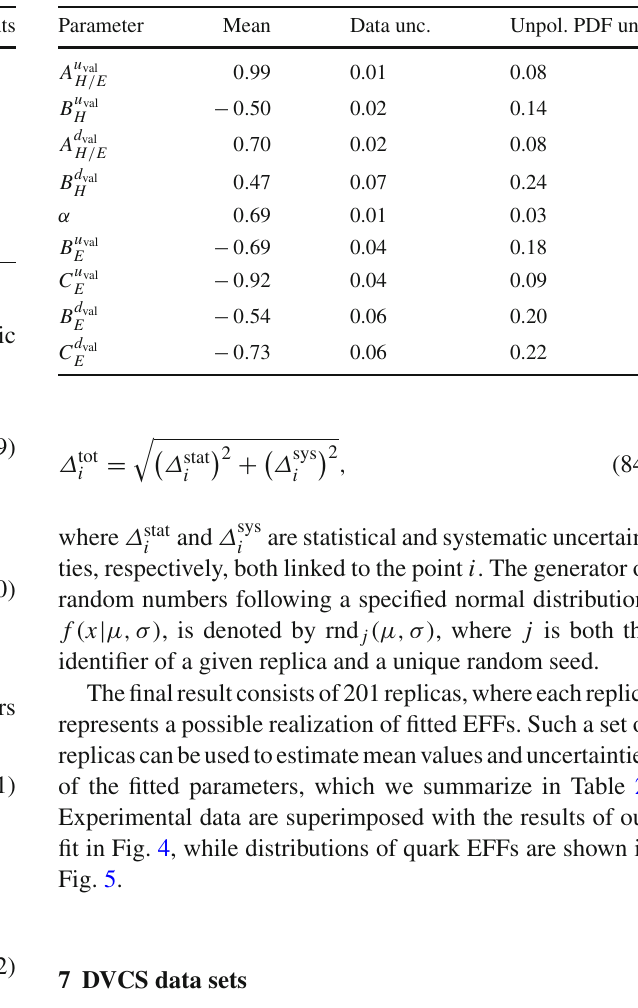
Table 1 EFF data used in this analysis. For R n we use data coming from Ref. [81], which are evaluated from those specified in this table